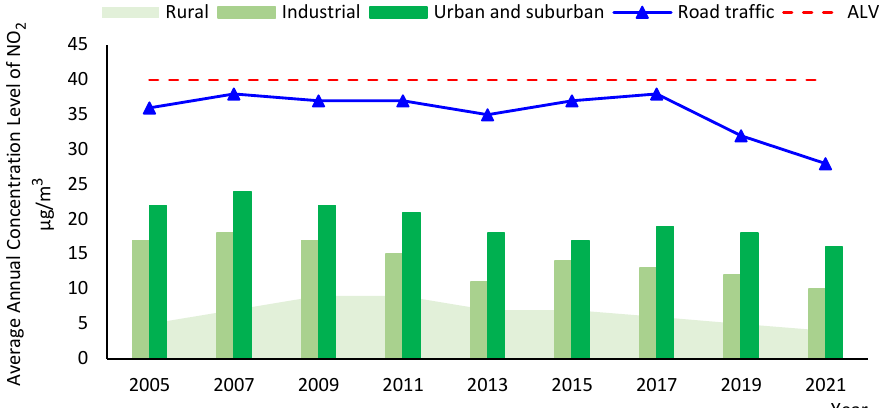
Figure 2. Trend analysis of NO 2 by type of station in Portugal (2005–2020). Source: authors’ creation based on data available from